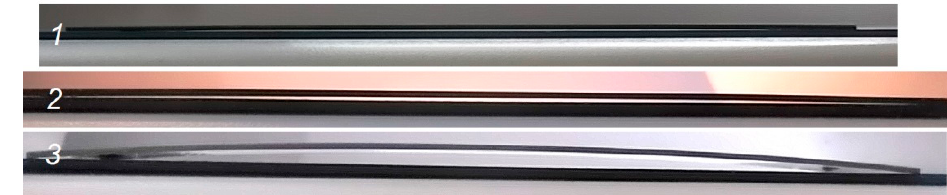
Figure 4. Side view of substrates: 1—initial anode substrate; 2 — after YSZ electrolyte film deposition, 3 — after 1200 °C annealing; YSZ electrolyte is deposited on top. As presented in Figure 5, the YSZ electrolyte films obtained at В and С points (see Figure 2a) do not change and remain transparent after 1200 °C annealing in air. As for point А , the film obtained with the large oxygen deficiency becomes opaque after annealing. This proves the light scattering on optical film defects. Since oxygen has a high solubility in zirconium, it can be easily inserted into the oxygen-deficient phase of zirconia.